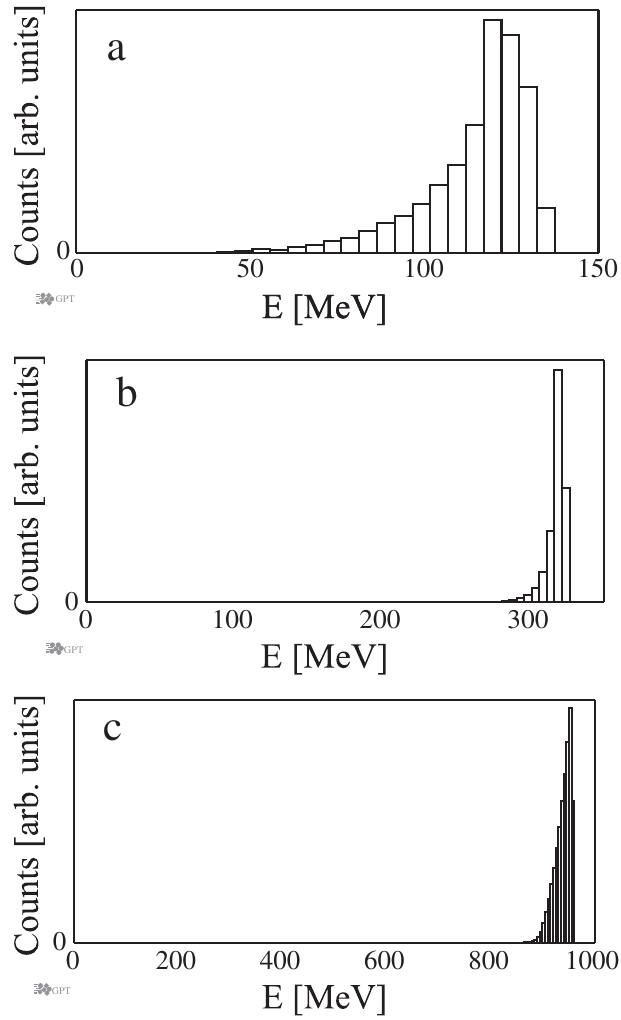
FIG. 7. Energy spectra of the accelerated bunches at their design settings (Table V) for the different laser regimes: a 0 ¼ ¼ 0 : 56 (b), and a ¼ 1 : 02 (c) with injection 300 fs 0 : 32 (a), a 0 0 in front of the laser pulse.